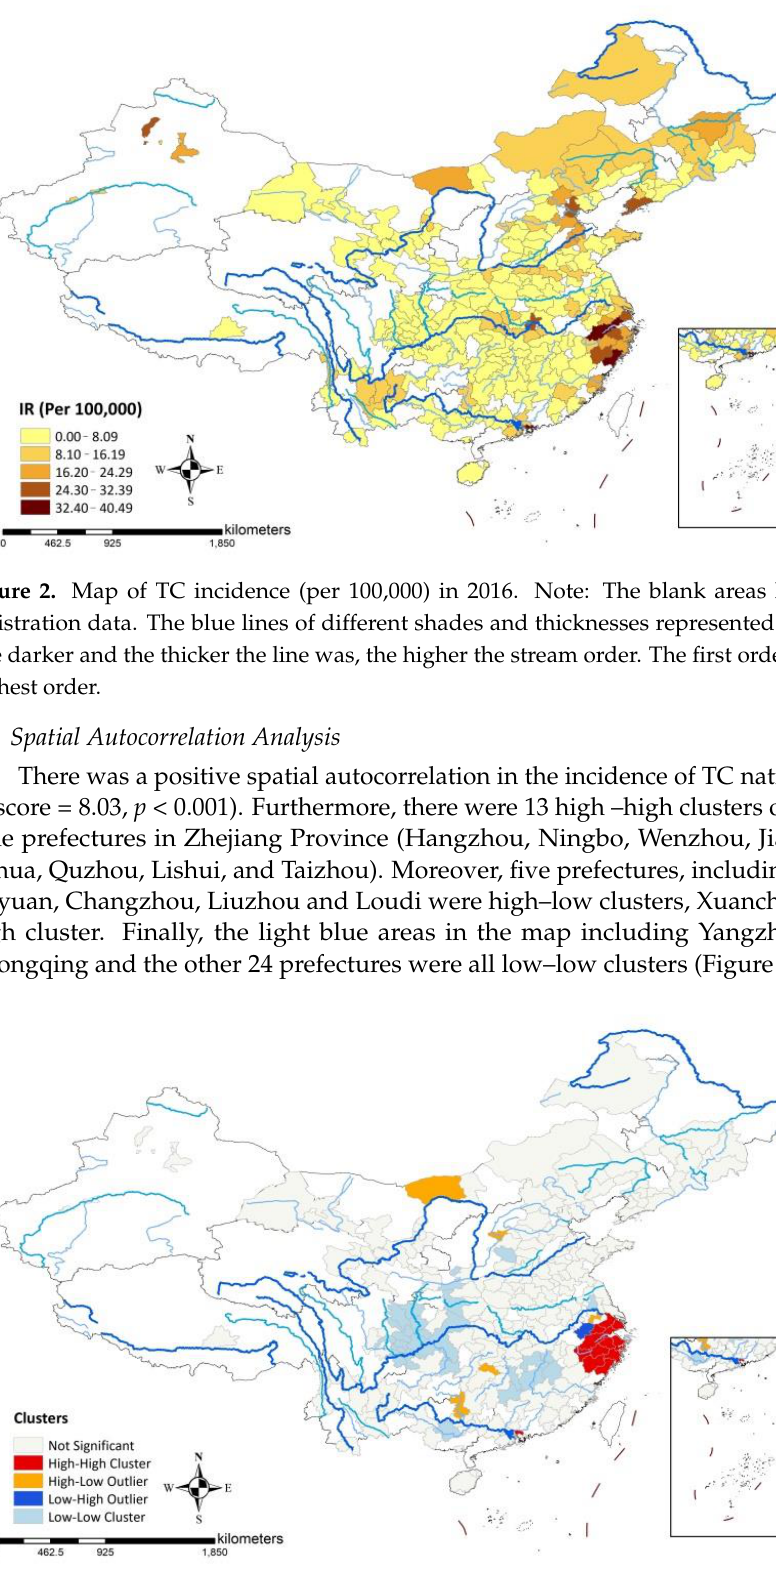
9.70 Note: crude incidence rate ( CIR ) , age-standardized incidence rate according to the world standard population ( IR ) . 3.2. Geographical Analysis On the whole, the incidence of TC in most areas of China was at a low level, the high incidence areas were mainly in the coastal areas, especially in Zhejiang Province in the southeast coast, which had the highest incidence of TC in China. Hangzhou had the